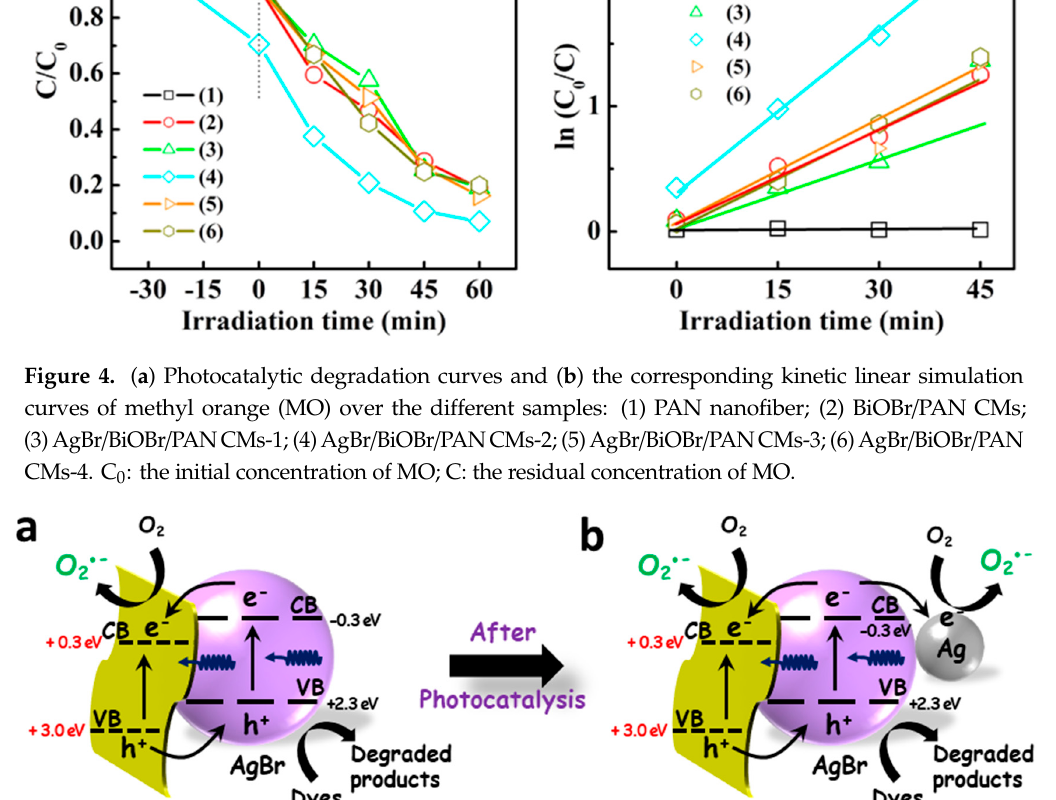
Figure 6. ( a ) Cycling test curves of the AgBr/BiOBr/PAN CMs-2 for the photocatalytic degradation of MO; ( b ) XRD patterns and SEM images of AgBr/BiOBr/PAN CMs-2 before and after three photocatalytic reactions.